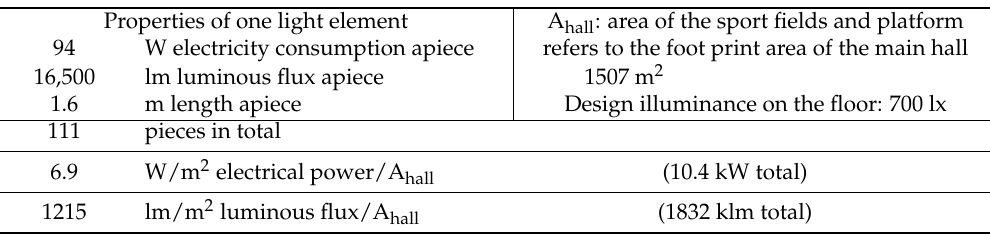
Table 3. Technical data of the realized lighting inside the main hall.